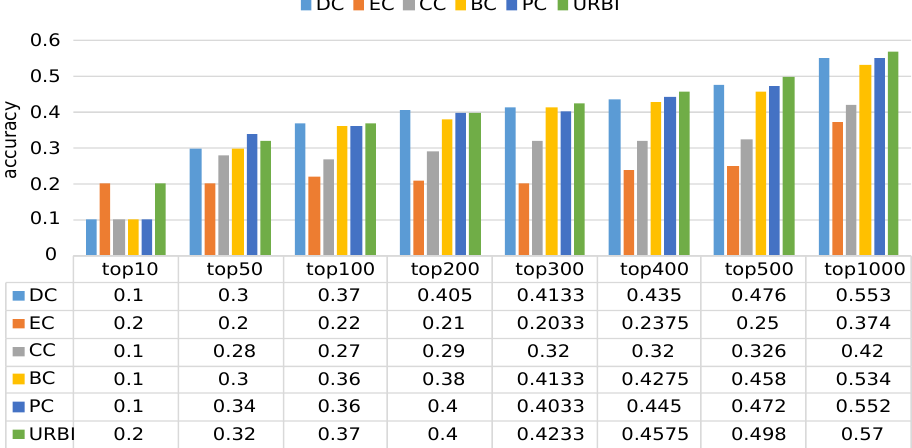
Figure 12. This figure depicts the experimental results of dataset No.12, which contains 9413 book